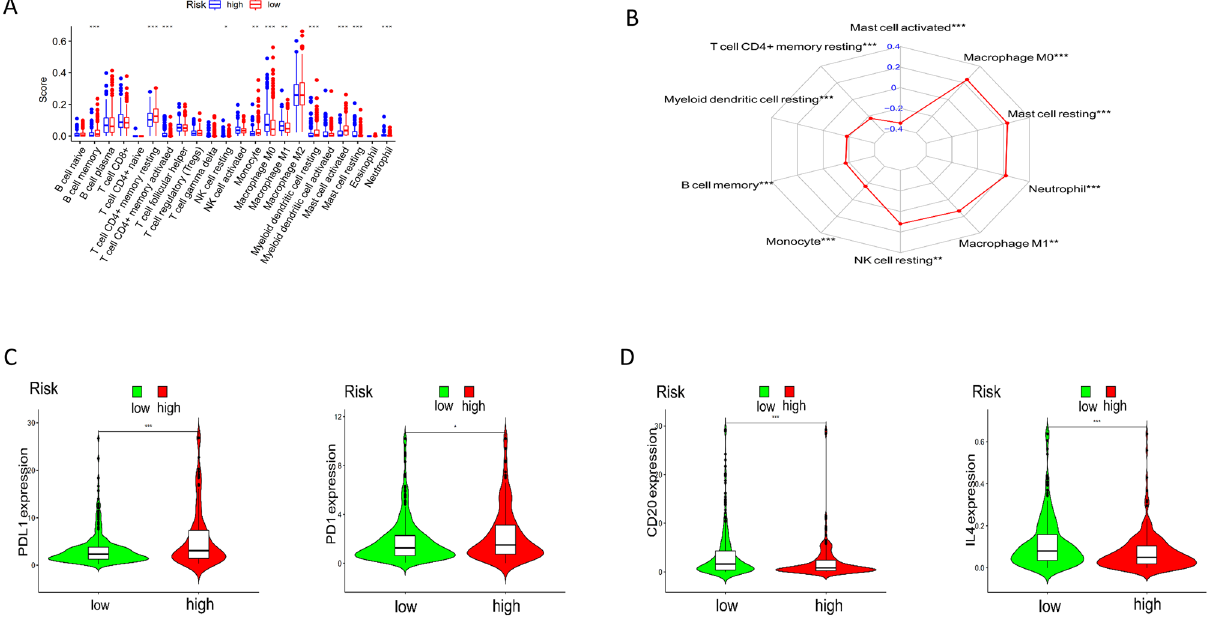
Figure 4. Compositions of infiltrated immune cells between different risk groups in TCGA-LUAD cohort. ( A ) The box plot shows the ratio differentiation of 22 kinds of immune cells between LUAD tumor samples with the high/low risk groups. ( B ) The radar chart shows the correlation between risk score and immune cell score. ( C , D ) Violin diagram shows the distribution level of immune related genes in high and low expression groups.